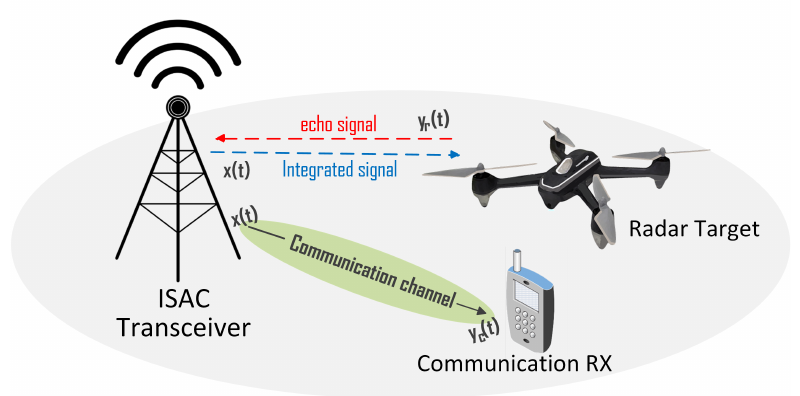
Figure 1. ISAC system